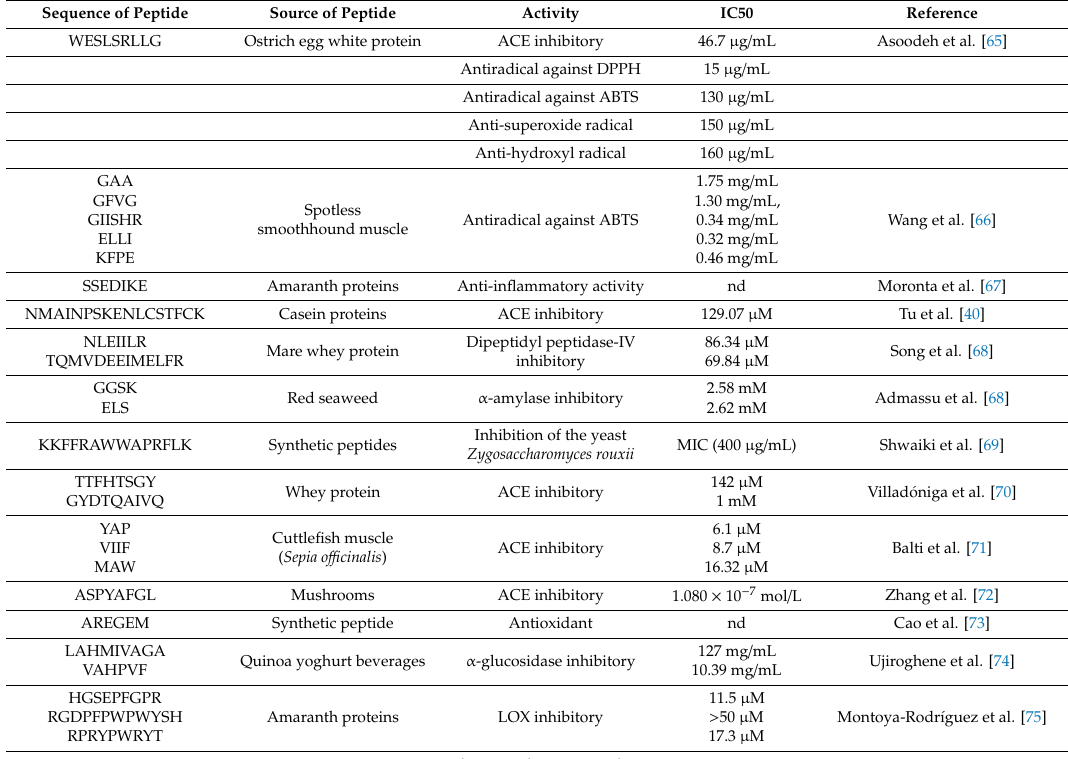
Table 1. Peptides with di ff erent